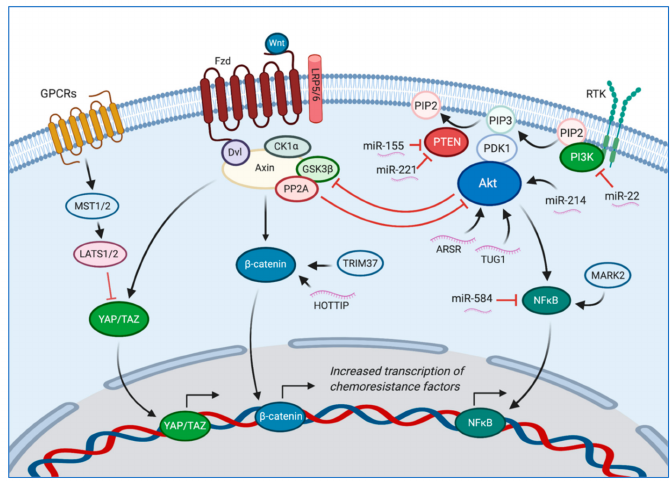
Figure 1. The canonical Wnt/ β -catenin pathway, the Hippo/YAP/TAZ pathway, and the PI3K/Akt pathway are each involved and have overlapping features that contribute to chemotherapy resistance and overall osteosarcoma progression. In the absence of Wnt, β -catenin and YAP/TAZ are bound to the Axin protein complex. YAP/TAZ recruits additional enzymes that ubiquitinate β -catenin and cause its degradation. Wnt activates the Frizzled (Fzd) and low-density lipoprotein receptor 5/6 (LRP5/6) coreceptors, which bind to disheveled (Dvl) and the Axin protein complex. This binding causes casein kinase 1 α (CK1 α ) and glycogen synthase kinase 3 β (GSK3 β ) to phosphorylate the cytoplasmic portion of LRP5/6 and further propagate Axin’s release of β -catenin and YAP/TAZ. β -catenin then translocates to the nucleus to activate genes participating in therapy resistance [25]. β -catenin expression is also decreased when lncRNAs HOTTIP is upregulated [37]. TRIM37 also activates the Wnt/ β -catenin pathway [29]. Free YAP/TAZ participates in the Hippo pathway, which upon activation causes hyper-phosphorylation of YAP/TAZ and prevents nuclear translocation [30,31]. Additionally, the PI3K/Akt pathway also participates in chemoresistance [35,36]. MiR-22 suppresses PI3K expression [38], while miR-155 and miR-221 suppress PTEN [39,40], miR-214 activates Akt by promoting its phosphorylation [41], and miR-584 inhibits NF κ B activity. MARK2 has also been shown to promote activation of the PI3K/Akt/NF κ B pathway [35]. ARSR and TUG1 promote Akt upregulation and activation [42,43]. Created with